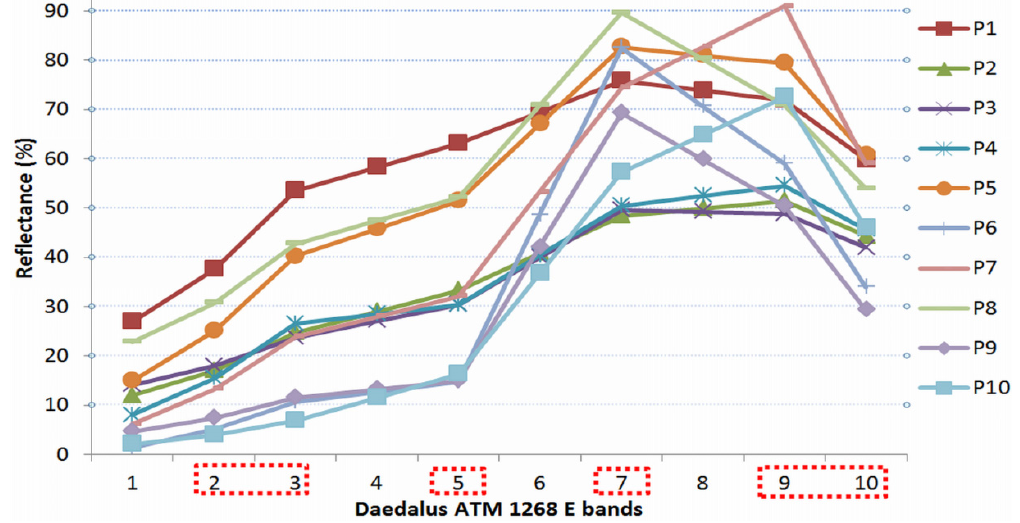
Figure 4. Point target (P1–P10) ground spectral signatures applied with ELM method. The dash-contoured x-labels indicate the ETM+ reflective bands